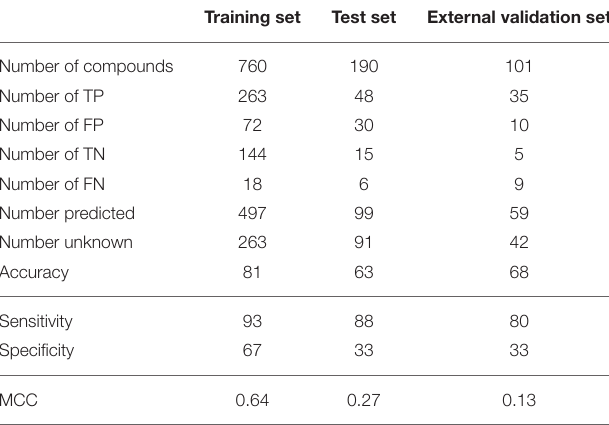
TABLE 2 | Performance of the model in the training, test and external validation sets. Training